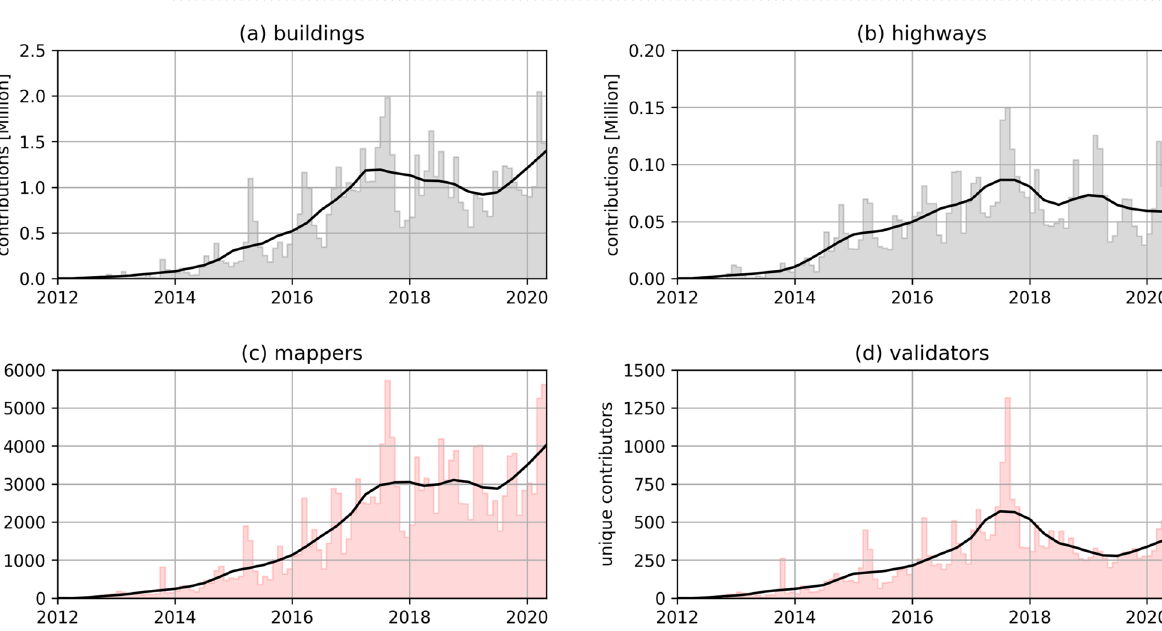
Figure 5. Monthly frequency distribution and trend cycle of humanitarian OSM contribution counts between 2012/01/01 and 2020/05/20 for ( a ) buildings and ( b ) highways and ( c ) mappers and ( d ) validators in HOT Tasking Manager. The line plots provide the trend line for each variable. Created using Matplotlib 3.3. in Python 3.7.5 (https ://www.pytho